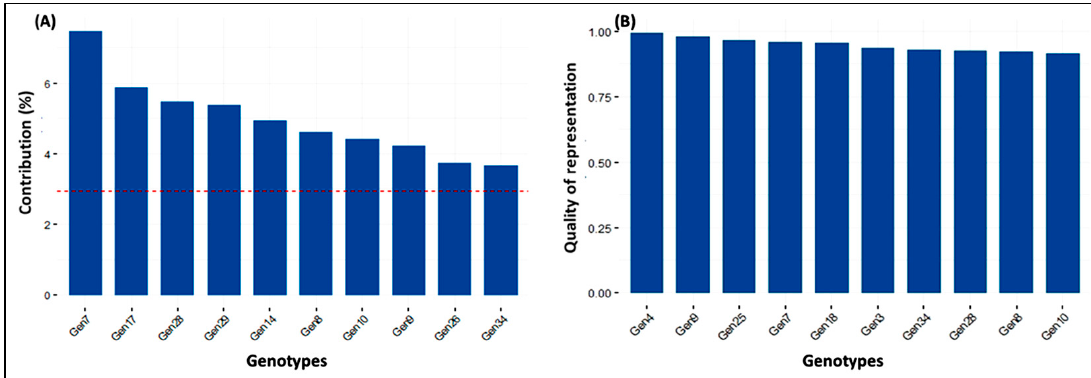
Figure 5. Graphical representation of ( A ) percent of contribution and ( B ) quality of representation of top 10 genotypes to principal components 1-2-3-4-5.